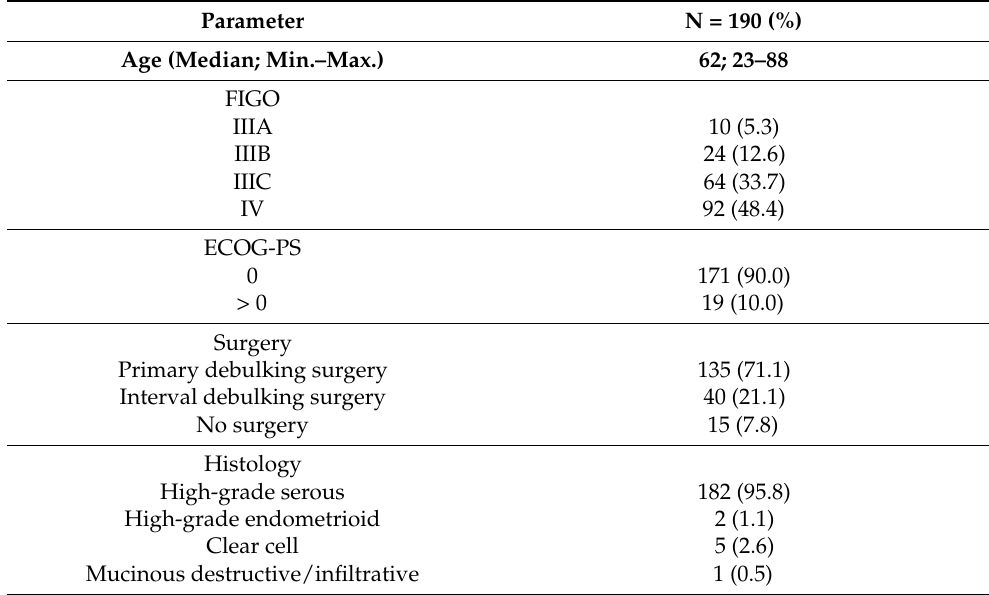
Table 1. Patients’ characteristics. FIGO—Federation of Gynecology and Obstetrics staging system; ECOG-PS—Eastern Cooperative Oncology Group performance score; HRD—homologous recombi- nation deficiency; and §—result with report of genomic instability score (GI-score). Parameter Age (Median;